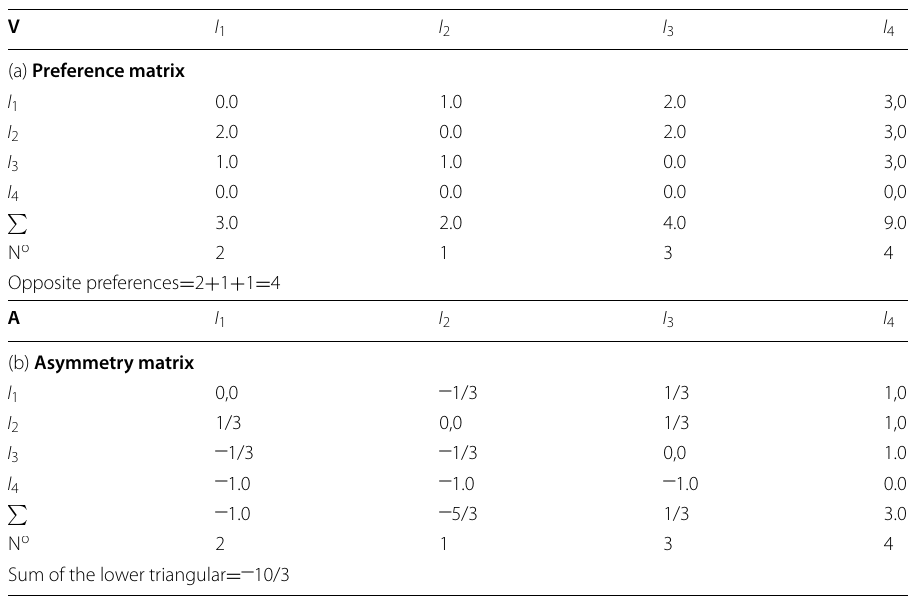
Table 4 The unordered aggregated preference and asymmetry